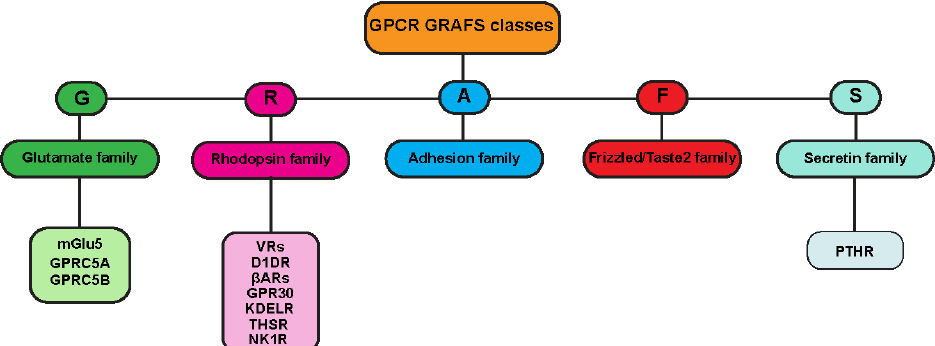
Figure 2. GPCR-GRAFS classification: GPCR alternative classification based on their phylogenetic analysis in mammalian system. In the GRAFS classification, receptors are divided into five families: glutamate-like family (G, green), rhodopsin-like (R, pink), adhesion-like family (A, blue), friz-